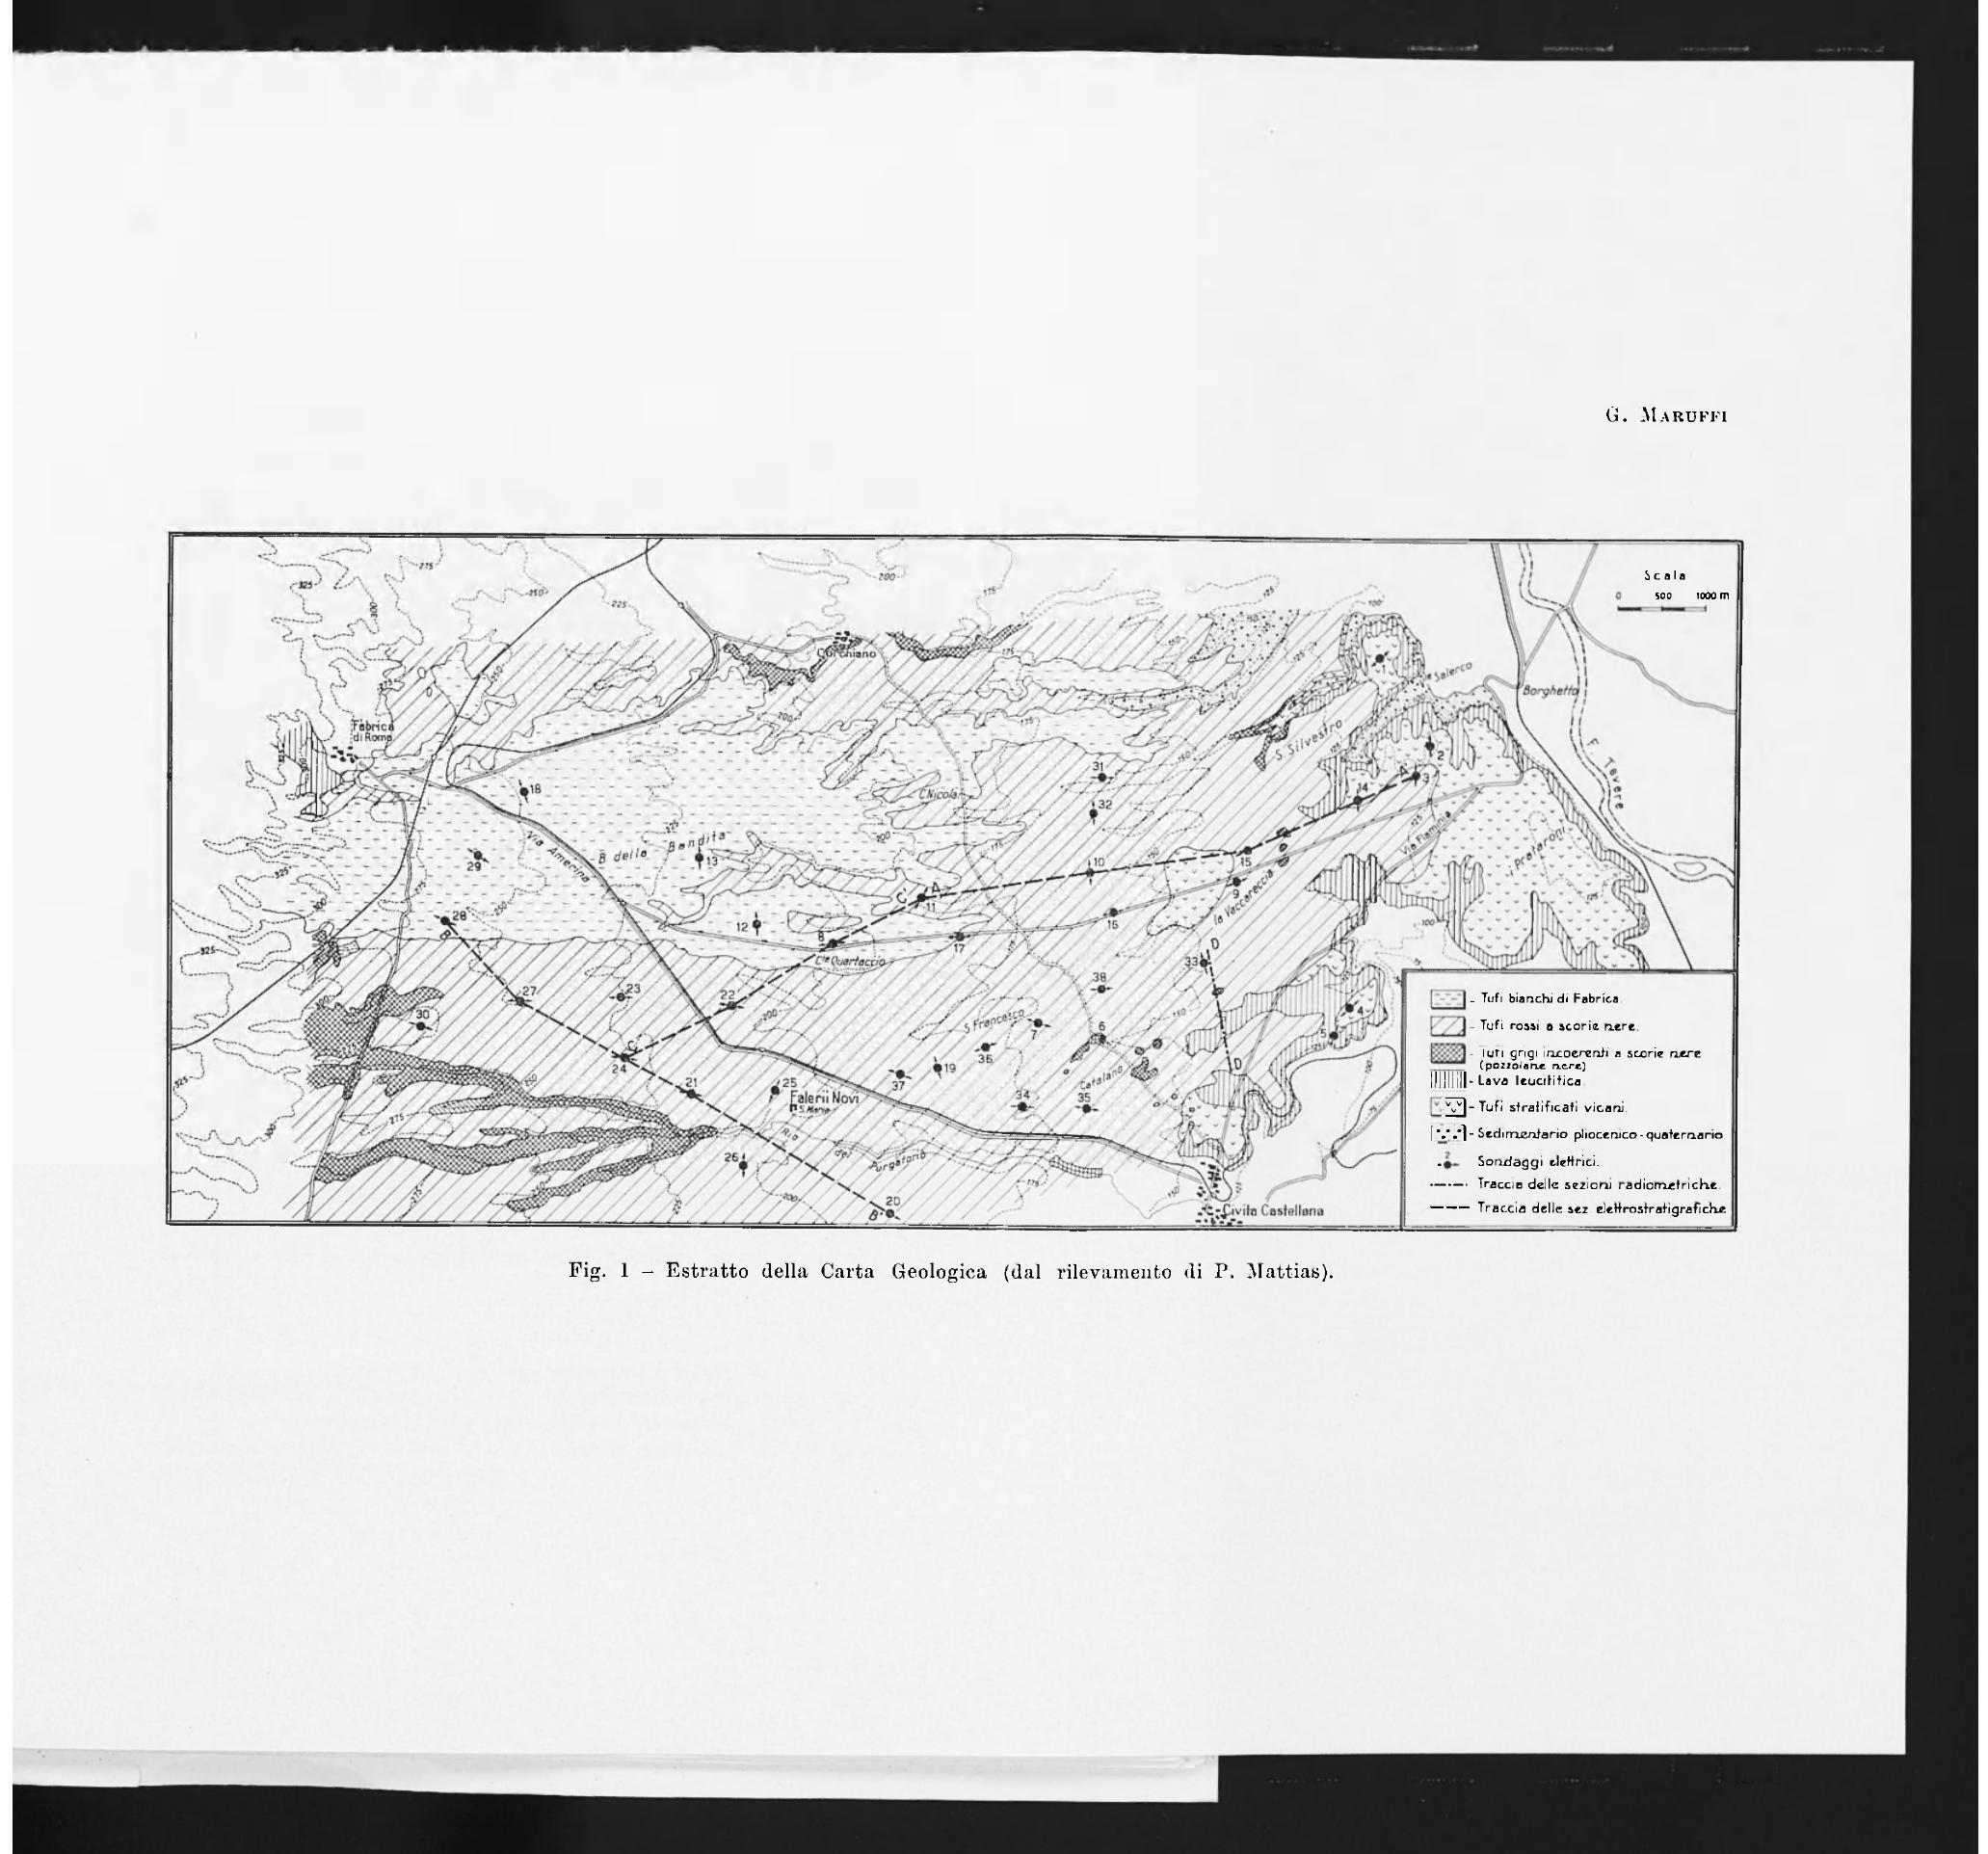
Fig. 1 - Estratto della Carta Geologica (dal rilevamento di P.